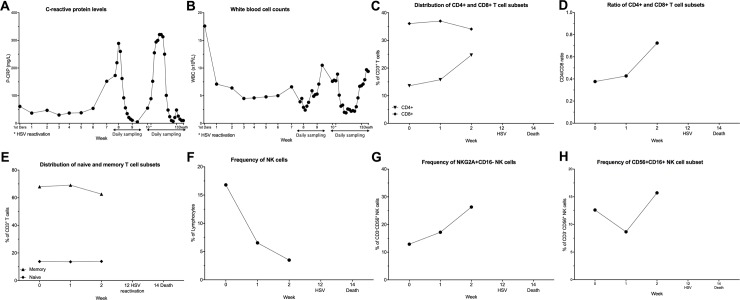
Clinical and immunological parameters from a patient with HSV infection during dara treatment.(A-B): The laboratory parameters CRP (A) and WBC at admission during the HSV-1 reactivation until the death of the patient are shown. (C-H) Peripheral blood samples were collected from patients throughout the Dara treatment. PBMCs were stained with lymphoid lineage markers and analyzed by flow cytometry, as described in experimental procedures. Frequencies of T cell and NK cells subsets are depicted. (C) percentages of CD8+ and CD4+ T cells and (D) CD4/CD8 ratio during Dara treatment (E) distribution of memory (CD45RA-CD45RO+) and naïve (CD45RA+CD45RO-) T cell subpopulation. In (F), total CD3-CD56+ NK cells as the percentage of lymphocytes and (G) CD56+CD16-NKG2A+ NK cells as the percentage of CD3-CD56+ NK cells are shown. (H) shows frequency of CD56+CD16- as the percentage of total CD3-CD56+ NK cells.